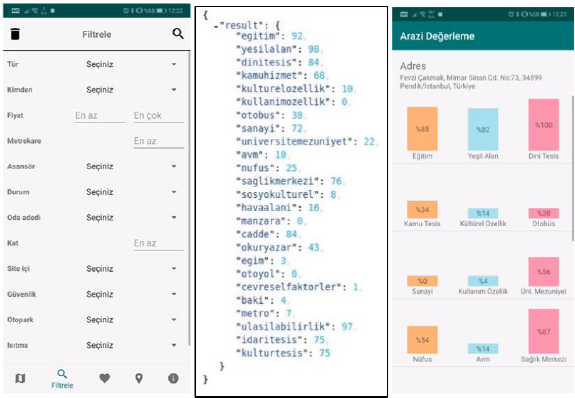
Figure 5. Real Estate Search function (left,) adValue Endpoint showing valuation records of received JSON data (mid) Value records with bar graphics